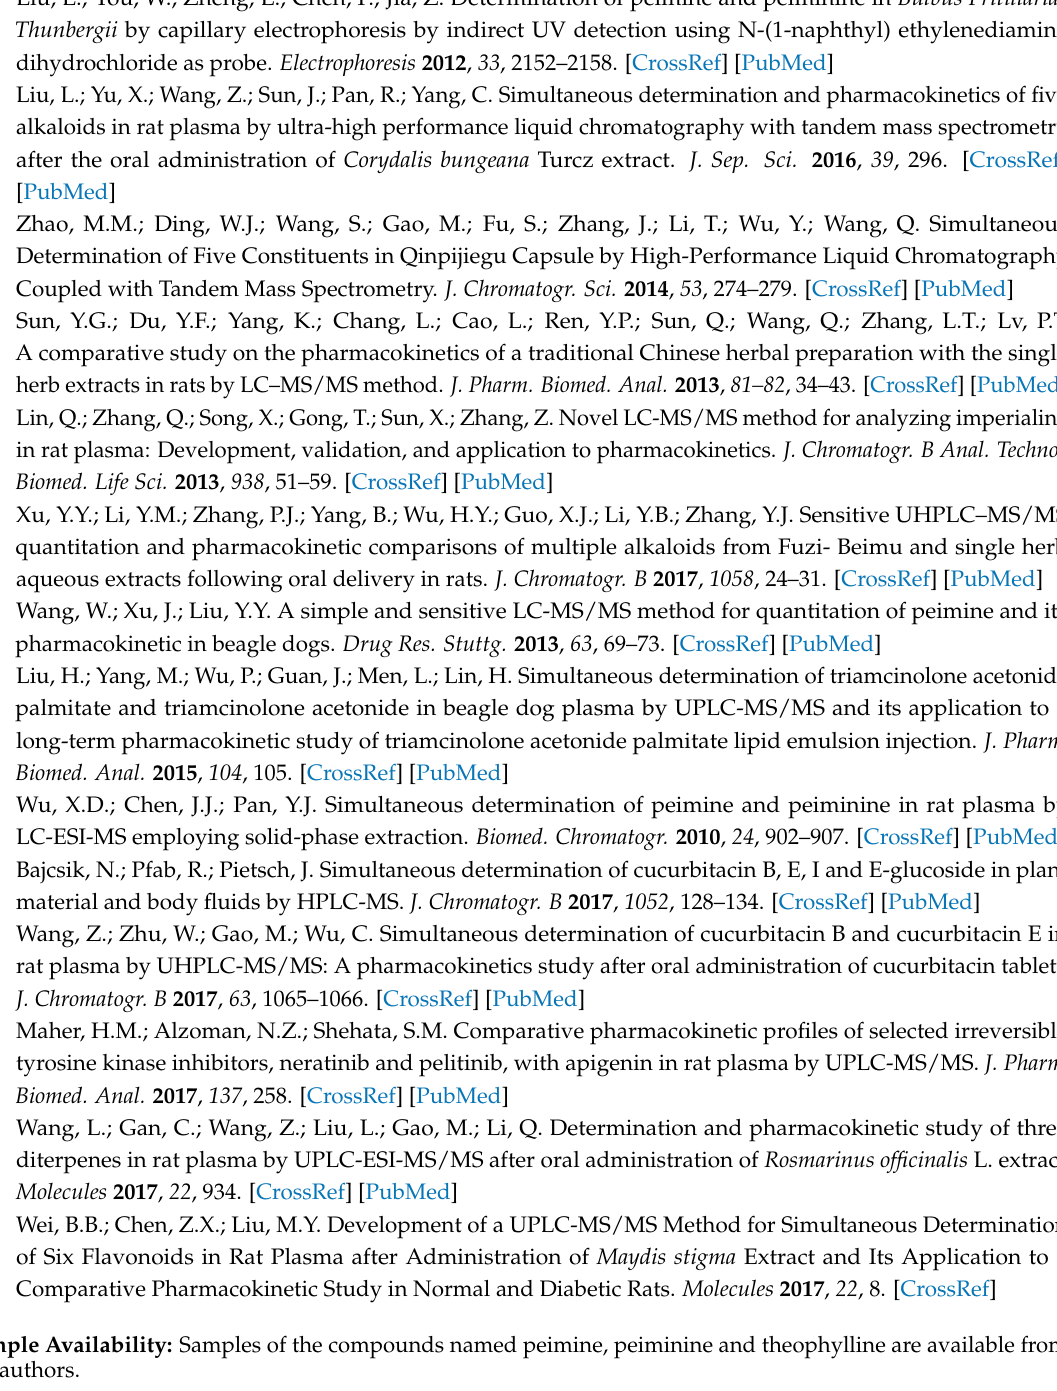
Sample Availability: Samples of the compounds named peimine, peiminine and theophylline are available from the